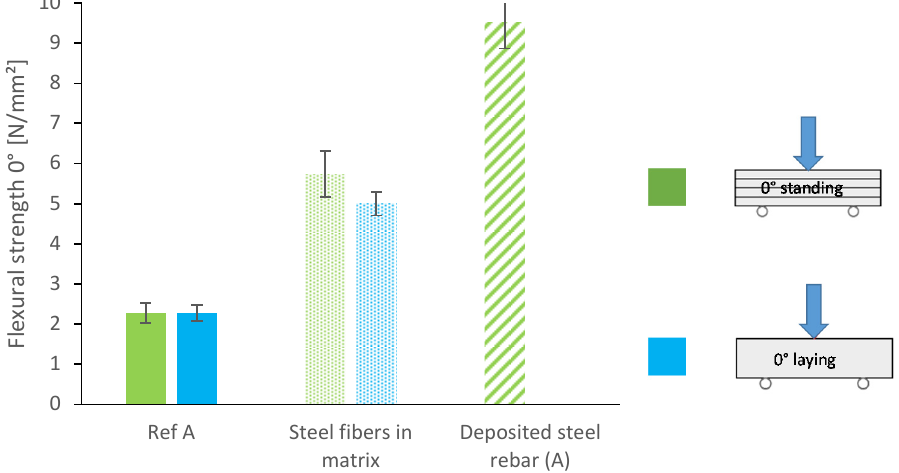
Figure 6. Flexural strength of lightweight mortar specimen: reference, with micro steelfibers and with deposited steel rebar (cut out 0° to printing direction, tested standing ( green ) and laying ( blue ).